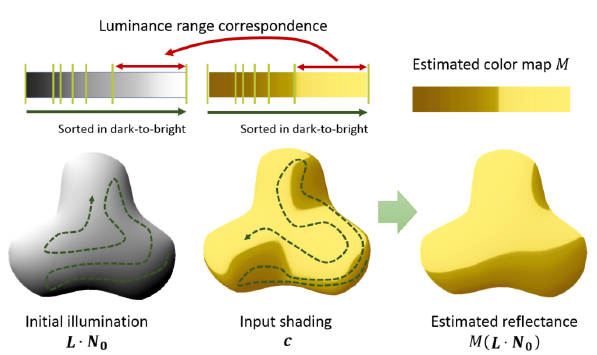
Fig. 6 Color map estimation. Given the set of illumination L · N 0 and original color c , a color map function M is estimated by matching the range of luminance